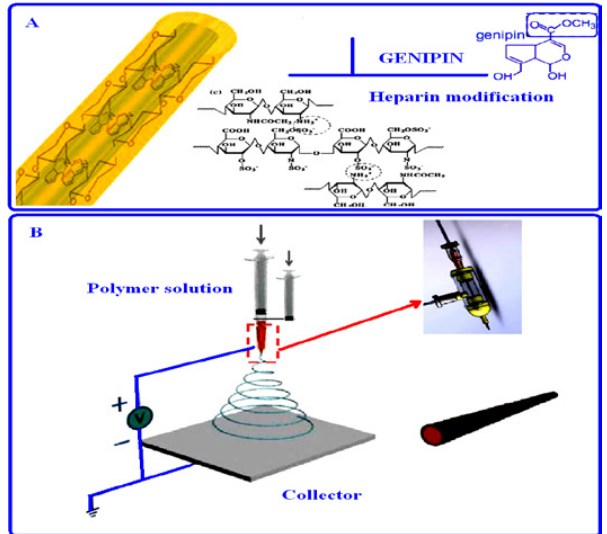
Fig. 4. (A) Illustration of electro - spinning of nano - scaffolds, (B) Illustration of polymer electro - spun[35]. Figure.4 : (A) Illustration of electro ― spinning of nano ― scaffolds, (B) Illustration of polymer electro ― spun [35] .